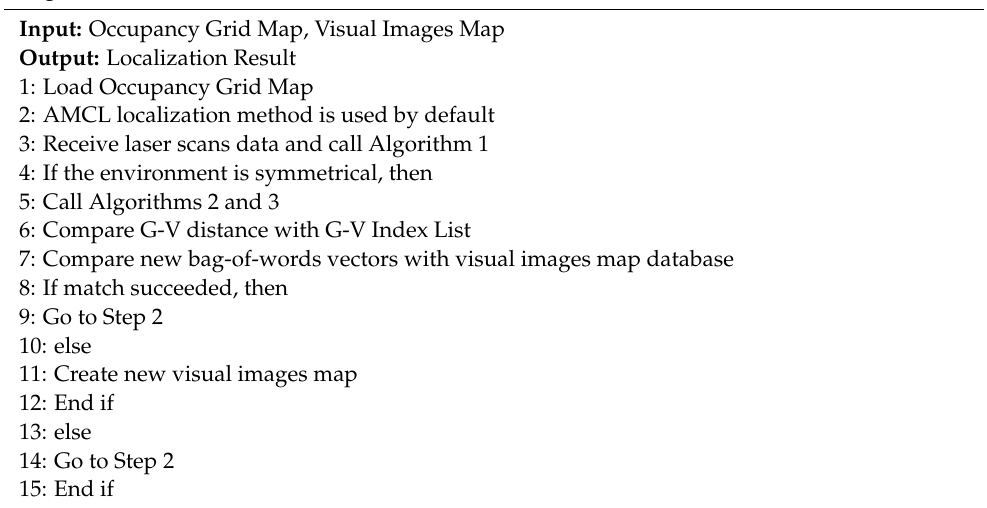
Algorithm 5. Localization